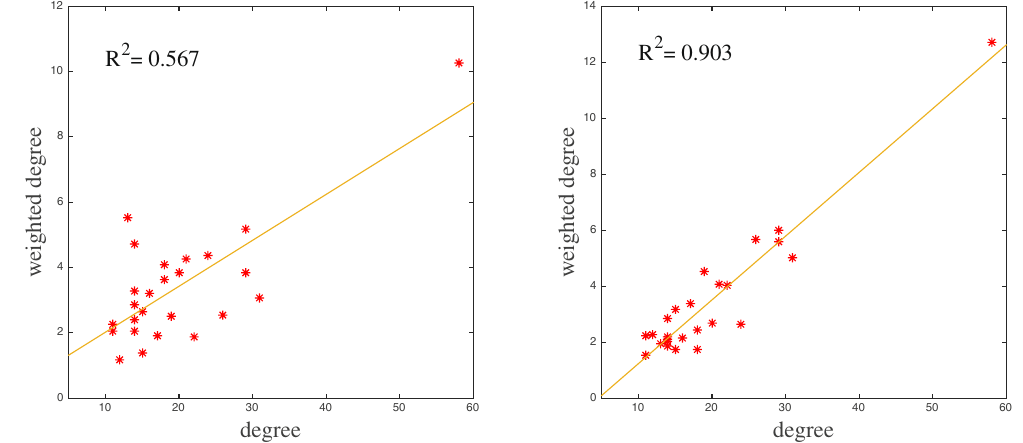
Figure 9. Weighted degrees against degrees of nodes of degree larger than 10 for the empirical contact network (left panel) and the randomly weighted network (right panel) used in Fig.